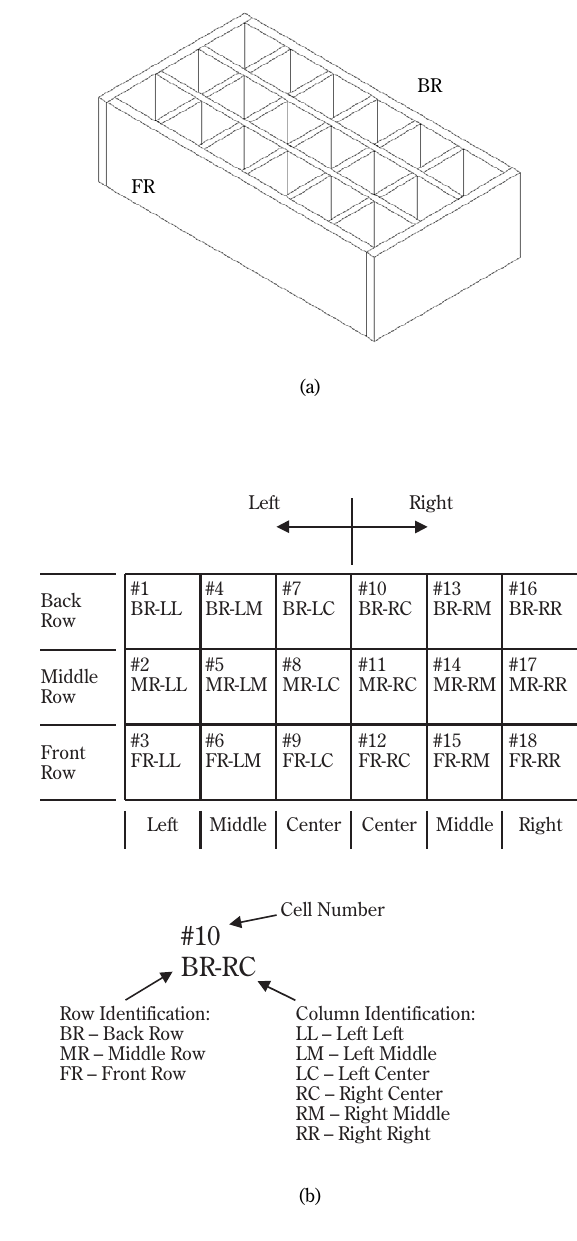
Schematic of global coordinates for the PSSC and the col- lection pan, underlined cell numbers are the measurement locations and h is the coarse material fill depth